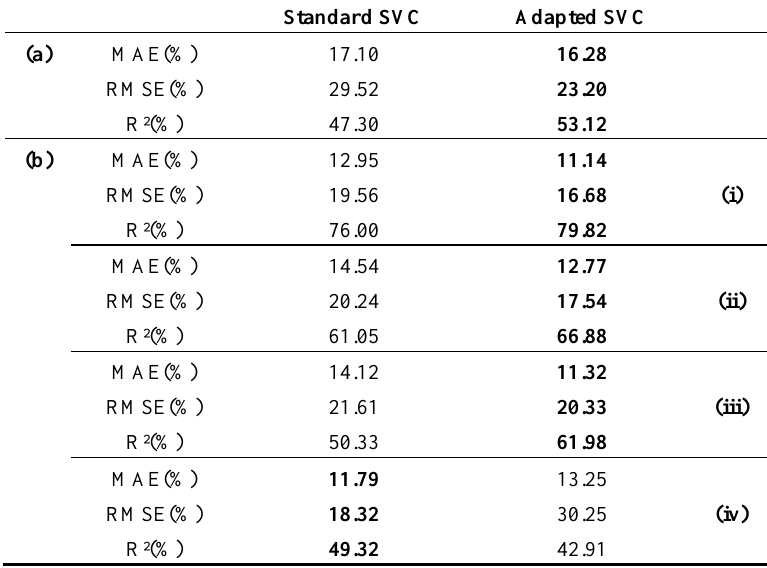
Table 3. Accuracies of shrub cover fraction maps derived from standard SVC and adapted SVC ( a ) for the entire study area and ( b ) for selected subsets. Statistics for the entire study area are derived from mean values of 200 iterations for an equalized random sample of 731 observations for each decile ( cf. Section 3.3). Higher accuracy values are